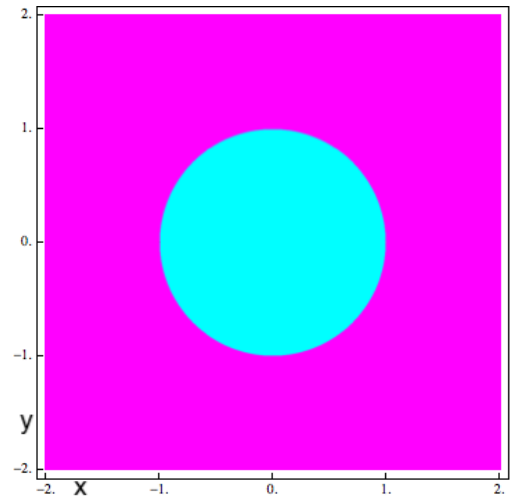
Figure 7. Basins of attraction associated with the member r = − 5 and t = −